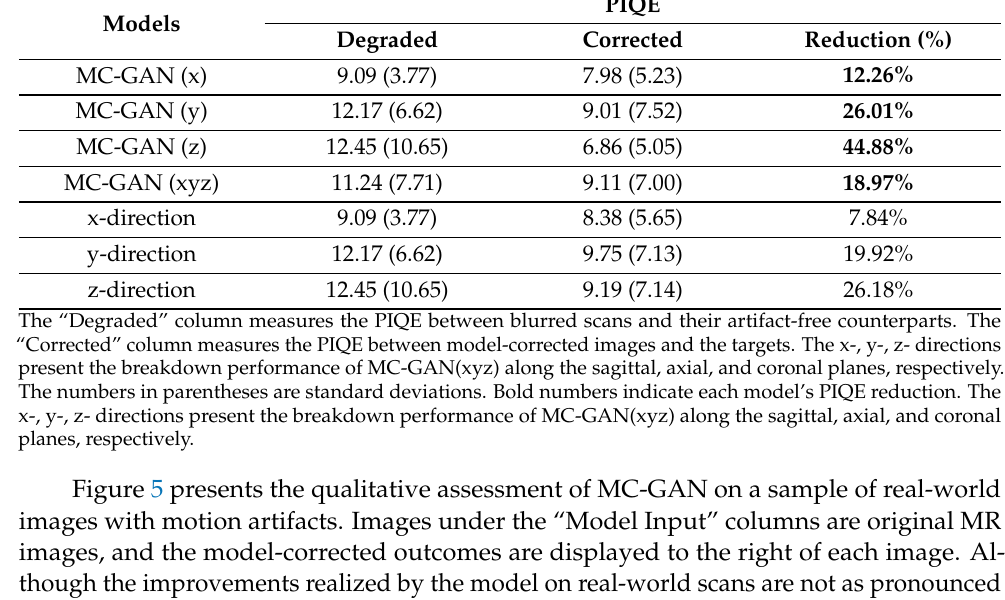
Table 2. Quantitative Evaluation on Real-world ABIDE data. Models